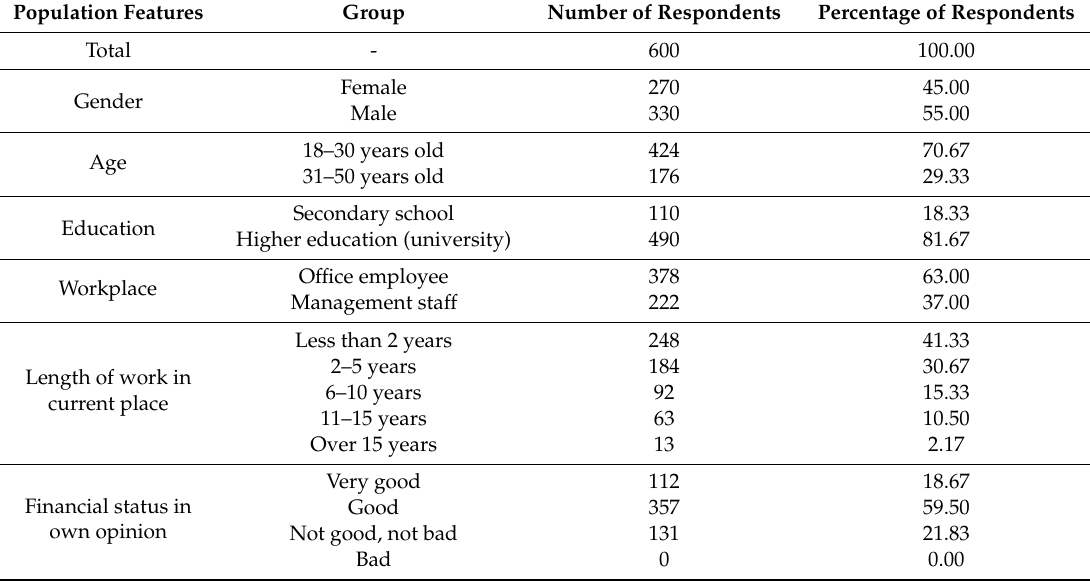
Table 1. Characteristics of